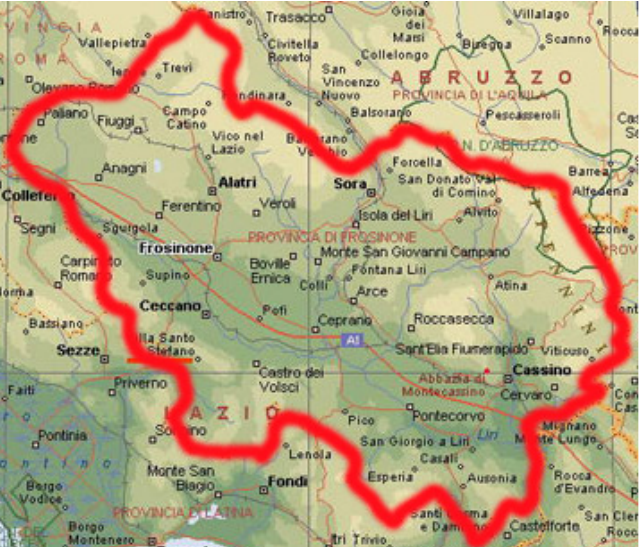
Figure 1. Provinces and municipalities of central Italy from which the patients a ff ected by K. pneumoniae and included in the database (see Section 2.2) came from.